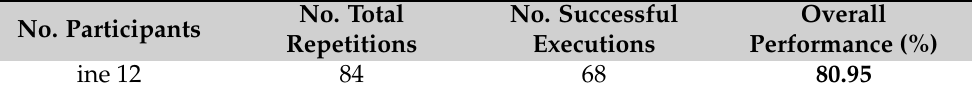
Table 2. Overall evaluation results on the assistance provision in the medication adherence